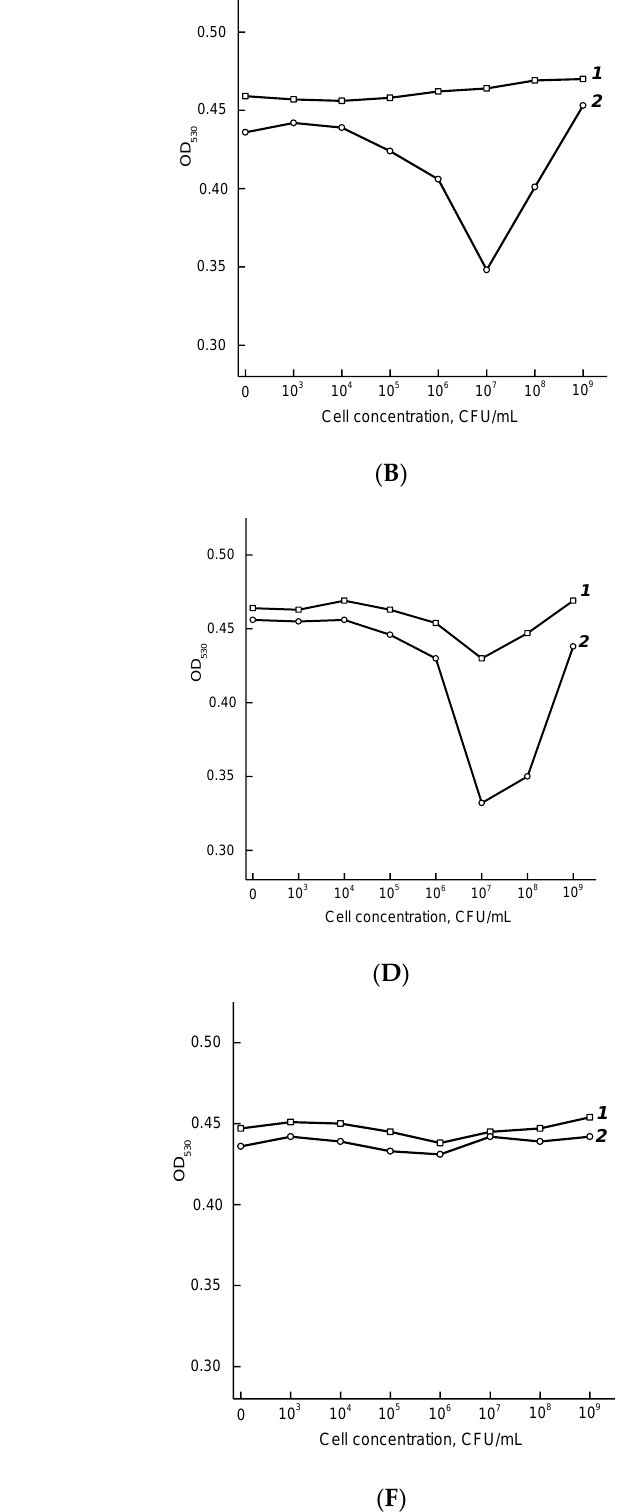
Figure 5. Agglutination of AuNPs2 – T143 conjugates in the presence of various concentrations of thermally inactivated F. tularensis subsp. holarctica 15 NIIEG ( A ) and 503 ( B ), F. tularensis subsp. mediasiatica 120 ( C ), F. tularensis subsp. tularensis Schu ( D ) and A-Cole B-399 ( E ), and F. tularensis subsp. novicida Utah112 ( F ). Curves 1 and 2 correspond to 1 and 20 min of reaction. Table 5 summarizes the minimum detectable cell concentrations of various F. tularen- sis strains. As can be seen, the LOD varies from 1 × 10 6 to 5 × 10 7 CFU/mL when using the AuNPs2 – Fb11 conjugate and from 5 × 10 4 to 5 × 10 6 CFU/mL when using the AuNPs2 – T143 conjugate. The AuNPs2 – T143 conjugate does not agglutinate in the presence of the non-virulent F. tularensis novicida Utah112 strain, which enables distinguishing virulent and non-virulent F. tularensis strains. Table 5. Minimum detectable concentrations of F. tularensis cells in the agglutination reaction with AuNPs2 – Fb11 and AuNPs2 – T143 conjugates. F. tularensis subsp.